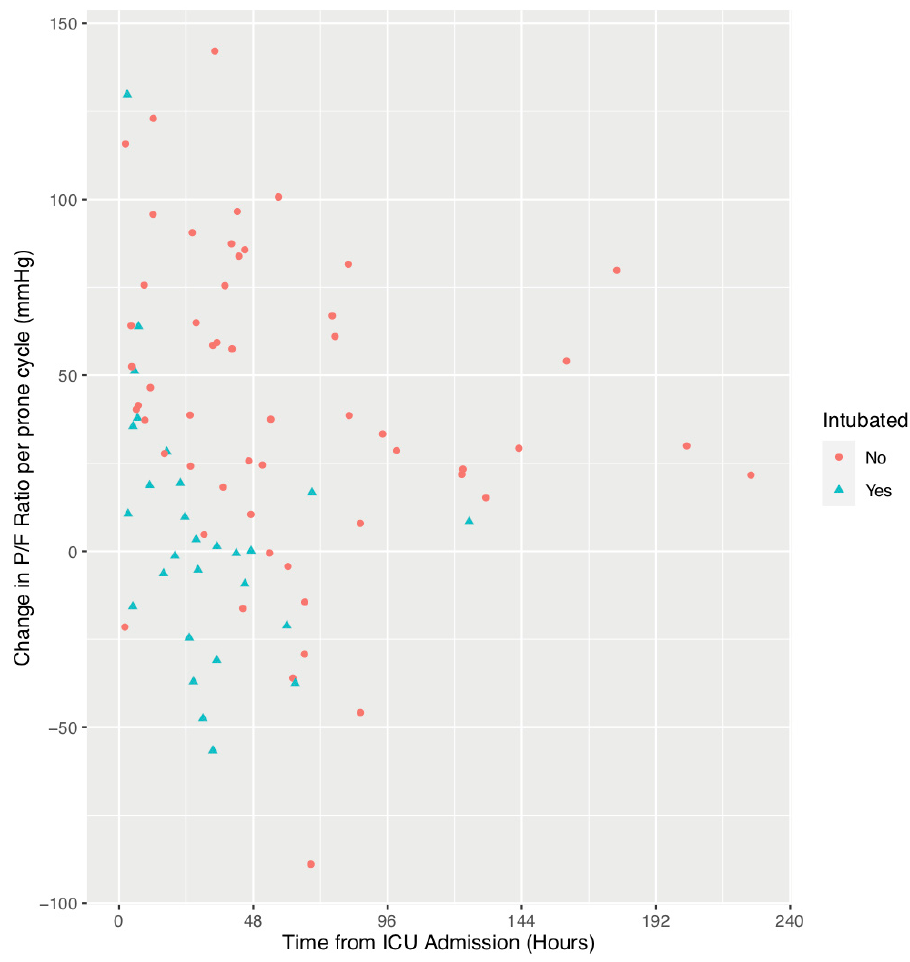
Figure 2. Pictorial representation of changes in the PaO2/FiO2 ratio for each prone cycle from all patients. Patients that failed non-invasive ventilation and required invasive mechanical ventilation (NIV+IMV group) are shown as blue dots and non-invasive ventilation (NIV) only group in red